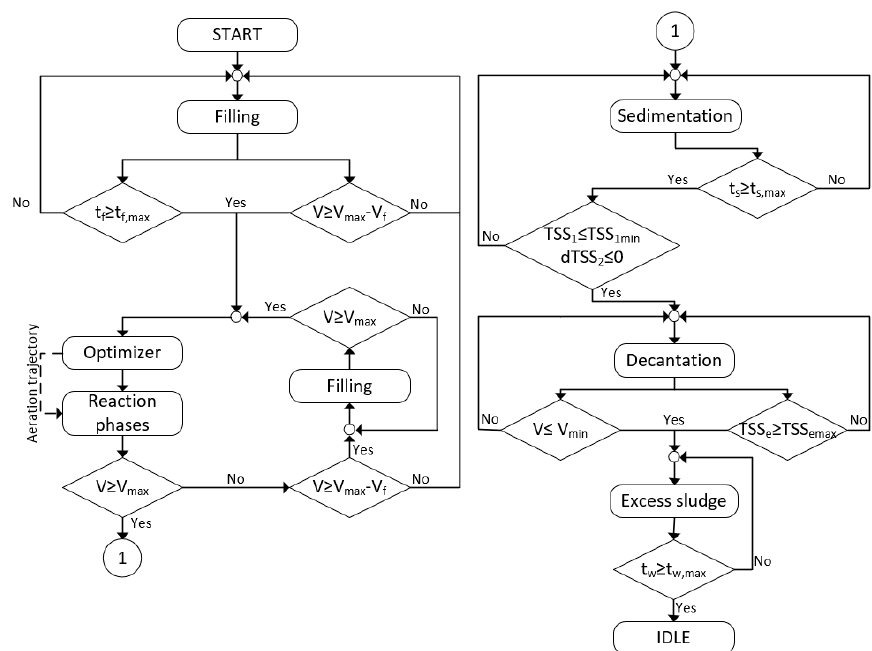
Figure 4. Block diagram of the work cycle: t f is the duration of the current filling [min]; t f , max is a time limit on filling [min]; t s is the duration of sedimentation [min]; t s , max is a time limit on sedimentation [min]; t w is the duration of excess sludge wasting [min]; t w , max is a time limit on excess sludge wasting [min]; V is the current volume of the wastewater-sludge mixture in the tank [m 3 ]; V max is the maximum capacity of the tank [m 3 ]; V min is the minimum volume of the mixture in the tank [m 3 ]; V f is the volume of the last filling [m 3 ]; TSS 1 is the concentration of the TSS in the top layer of the tank and TSS 1 min is its limit [g/m 3 ]; TSS e is the concentration of the TSS in the effluent and TSS emax is its limit [g/m 3 ]; dTSS 2 — derivative of the TSS concentration in the middle layer of the reactor [g/m 3 ].